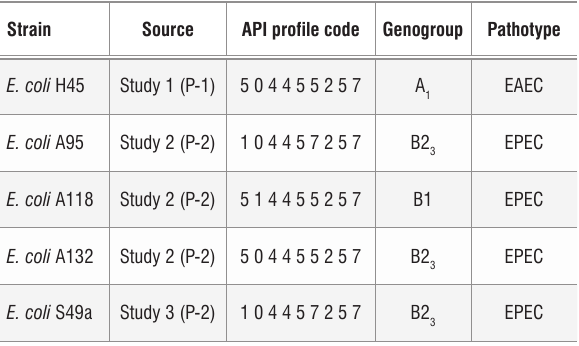
Antimicrobial resistance testing